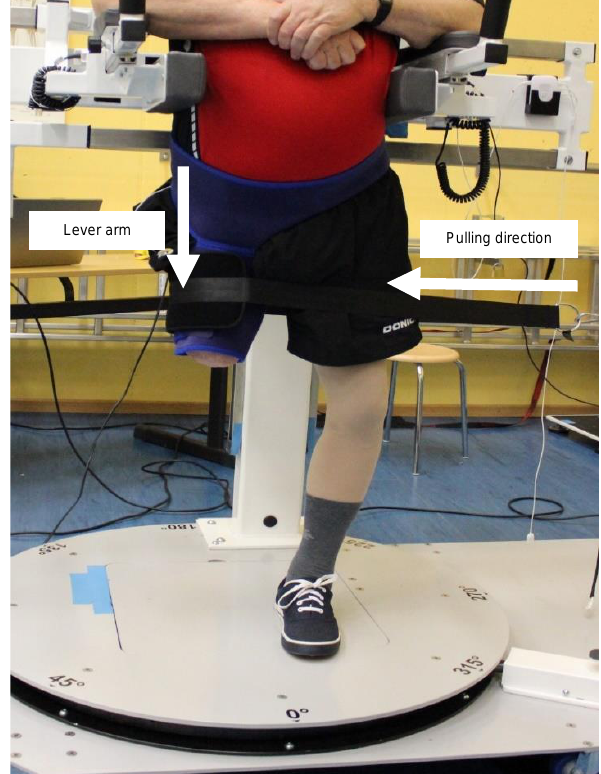
Figure 2: Setup for measuring strength in hip abduction in the neutral hip